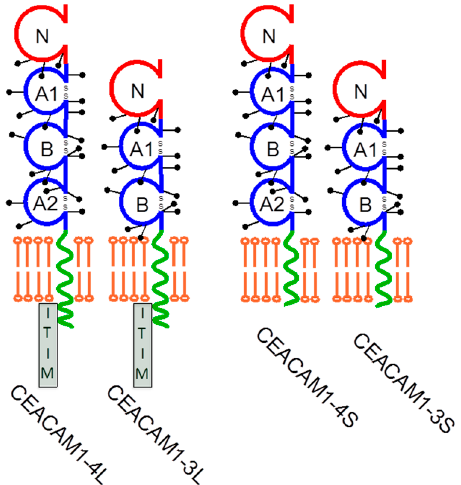
Figure 1. The four mainly expressed splice variants of human CEACAM1. Alternative splicing of CEACAM1 generates isoforms, which consists of one N-terminal ectodomain followed by either three or four extracellular Ig-like domains, a conserved transmembrane domain, and a short (CEACAM1-4S and 1-3S) or long cytoplasmic (CEACAM1-4L and 1-3L) domain. The long cytoplasmic domain encodes two ITIMs (immunoreceptor tyrosine-based inhibitory motif) that bind SHP-1 and SHP-2 when phosphorylated and convey inhibitory activities to CEACAM1-4L. The short and long cytoplasmic domains have been shown to interact with intracellular molecules such as actin and calmodulin. Interestingly, CEACAM1 is expressed in a cell type and activation stage dependent manner with significant differences in the ratios of its short and long